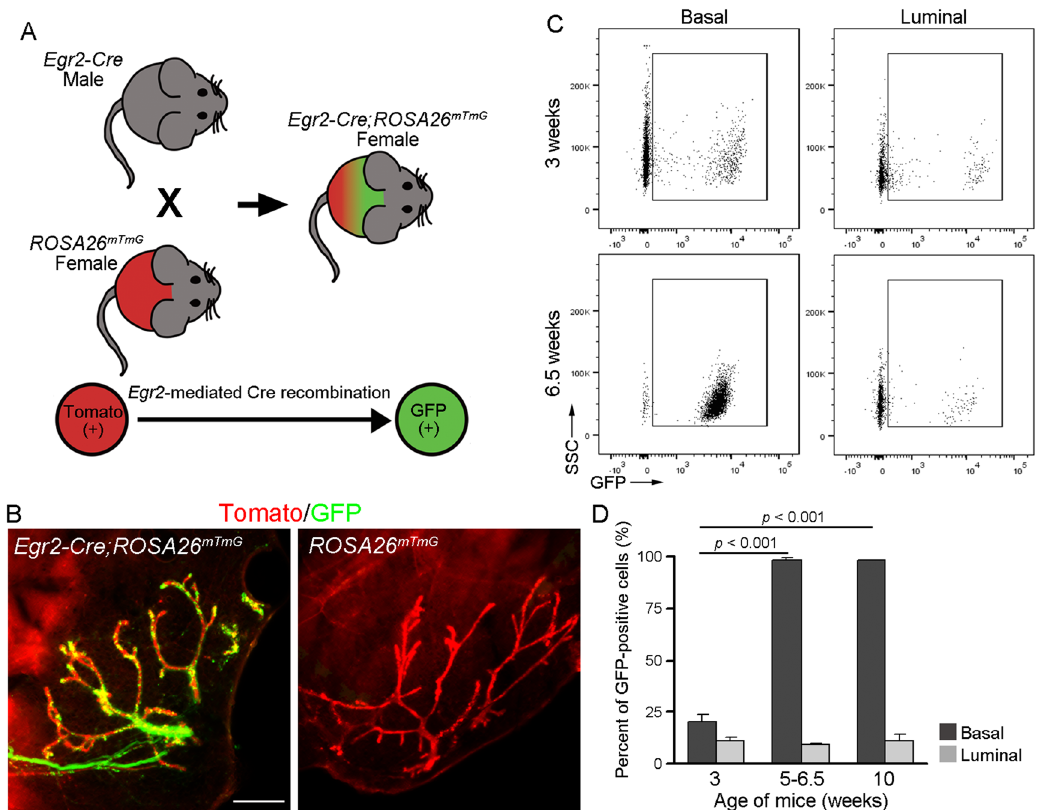
Figure 5. Genetic labeling of Egr2 -expressing cells and progenies in mammary gland. ( A ) Experimental design. ( B ) Whole-mount imaging of GFP and tdTomato fluorescence in mammary gland from 3-week-old Egr2-Cre;ROSA26 mTmG or ROSA26 mTmG mice. Scale bar = 500 μm. ( C , D ) Representative flow profiles ( C ) and summary bar plots ( D ) displaying the number of GFP-positive cells in basal and luminal cells during pubertal mammary development. p value was generated using a Student’s t -test. n = 3 Egr2-Cre;ROSA26 mTmG mice per age